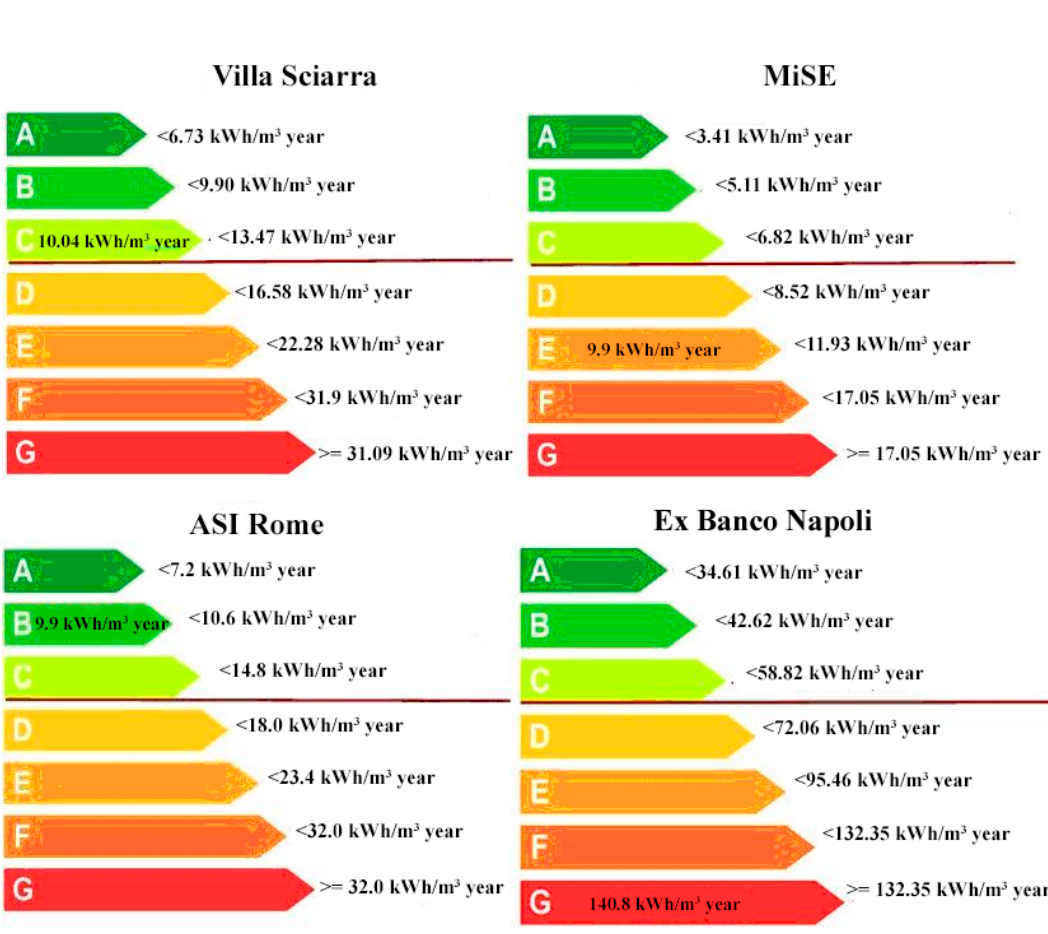
Figure 2. Actual energy performance of the analyzed buildings ( EP gl values). Figure 3. Villa Sciarra ceiling stratigraphy before and after the insulation intervention. Table 2. Villa Sciarra floor stratigraphy before intervention.